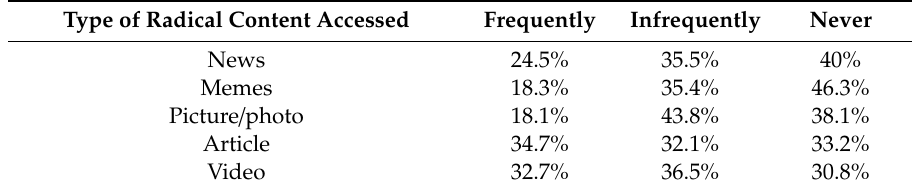
Table 5. Radical Contents that Have Been Accessed by Students.